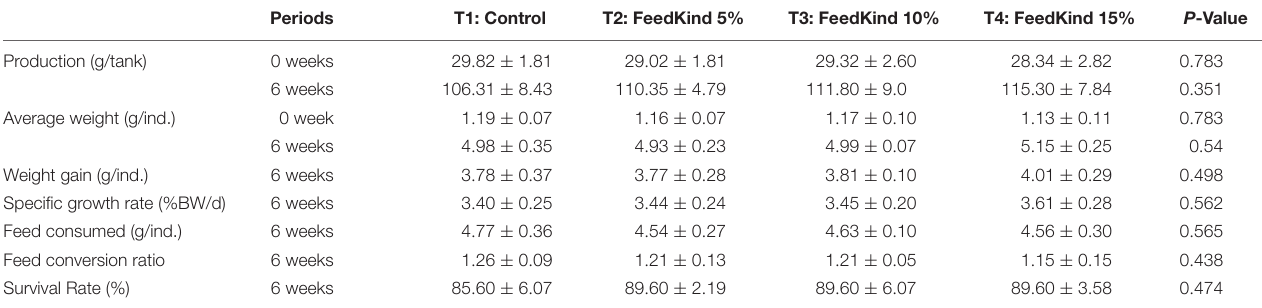
TABLE 2 | Growth performance of white shrimp ( n = 25 for each replicate and each time period) fed different level of methanotroph bacteria meal for 6 weeks.